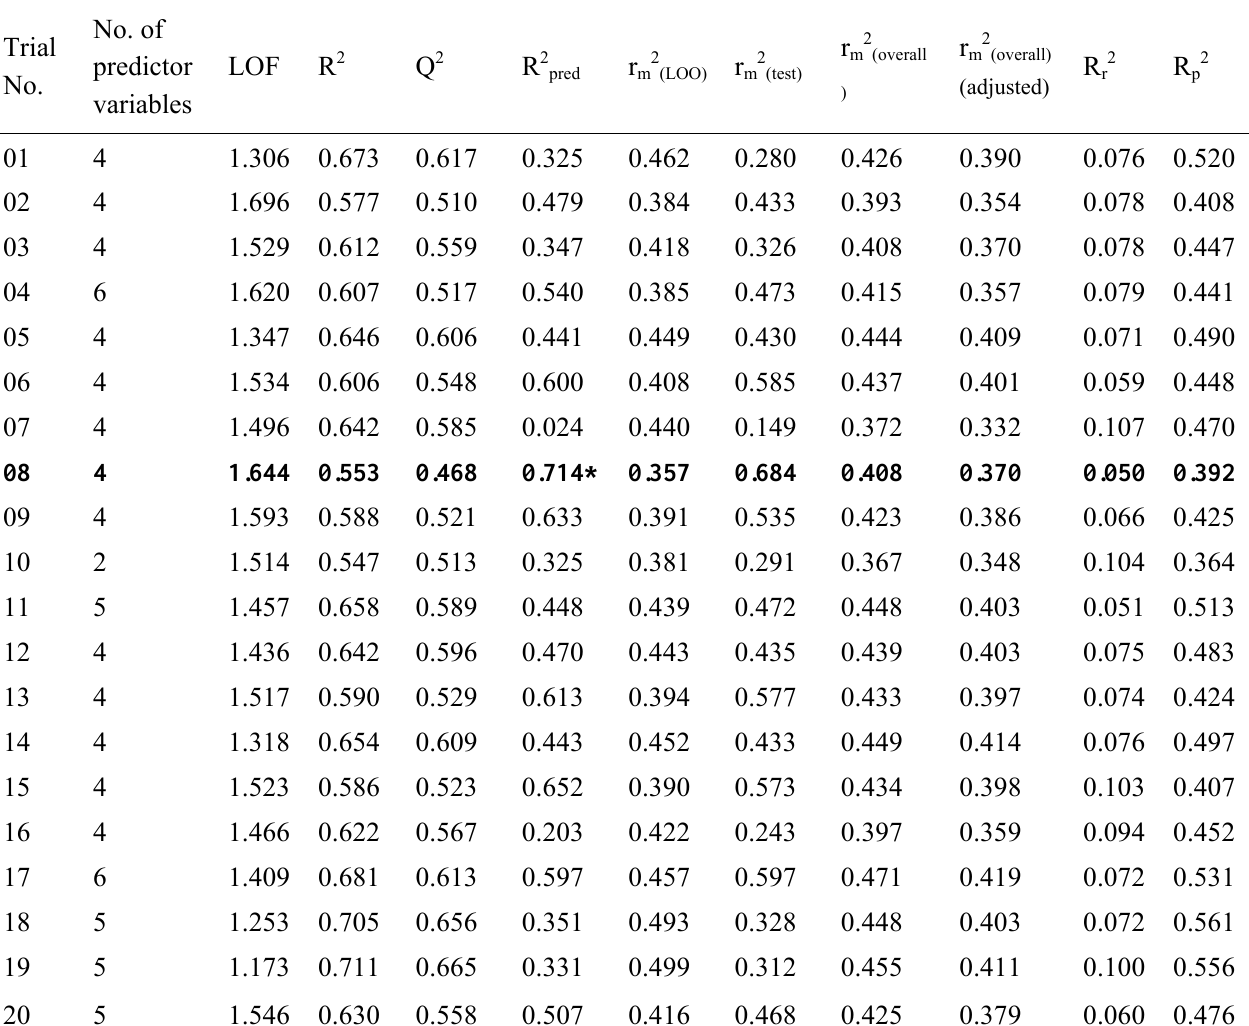
Table 5. Comparison of statistical qualities and validation parameters of different models (Data set